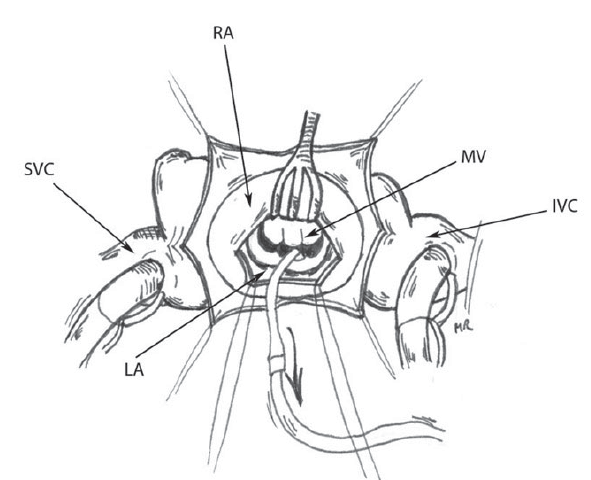
Fig. 2 - Access to the mitral valve after the inter-atrial septum is retracted with a standard mitral retractor. (svc = superior vena cava, RA = right atrium, MV = mitral valve, IVC = inferior vena cava, LA= left atrium, TV= tricuspid valve, CS= coronary